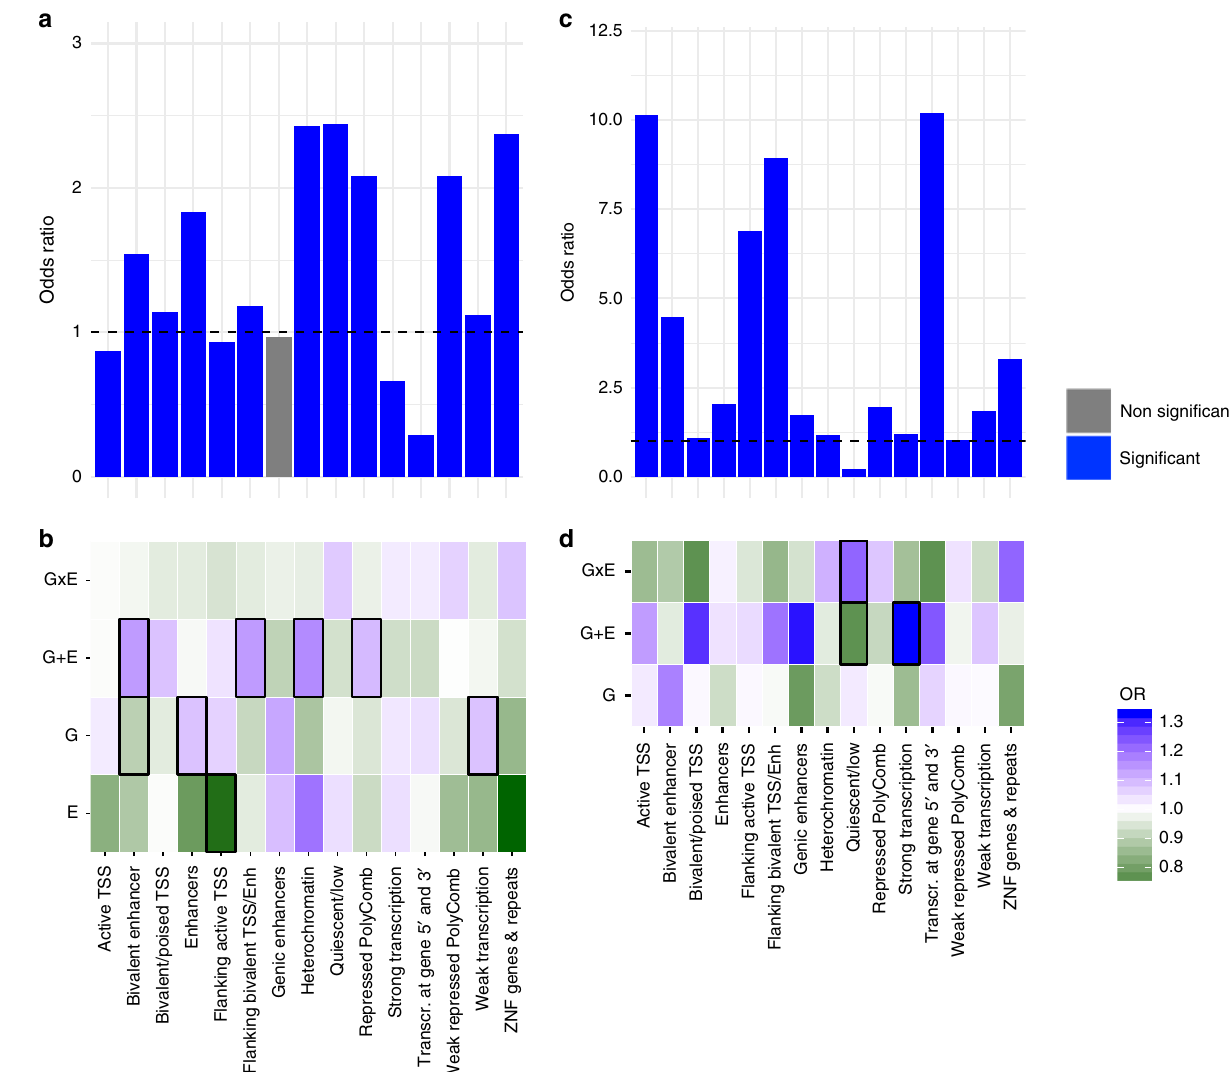
Fig. 4 Functional annotation of VMR-mapping in DeepSEA annotated SNPs in PREDO I dataset. a Histone mark enrichment for all VMRs. The Y-axis denotes the fold enrichment/depletion as compared to no-VMRs. Blue bars indicate signi fi cant enrichment/depletion, grey bars non-signi fi cant differences based on Fisher-tests. b Histone mark enrichment for tagVMRs with best model E, G, G + E and GxE relative to all VMRs. Green colour indicates depletion, red colour indicates enrichment. Thick black lines around the rectangles indicate signi fi cant enrichment/depletion based on Fisher-tests. c Histone mark enrichment for all DeepSEA variants in the dataset. Blue bars indicate signi fi cant enrichment/depletion based on Fisher-tests. d Histone mark enrichment for all DeepSEA variants involved in models where either G, G + E or GxE is the best model as compared to all tested DeepSEA variants. Green colour indicates depletion, red colour indicates enrichment. Thick black lines around the rectangles indicate signi fi cant enrichment/depletion based on